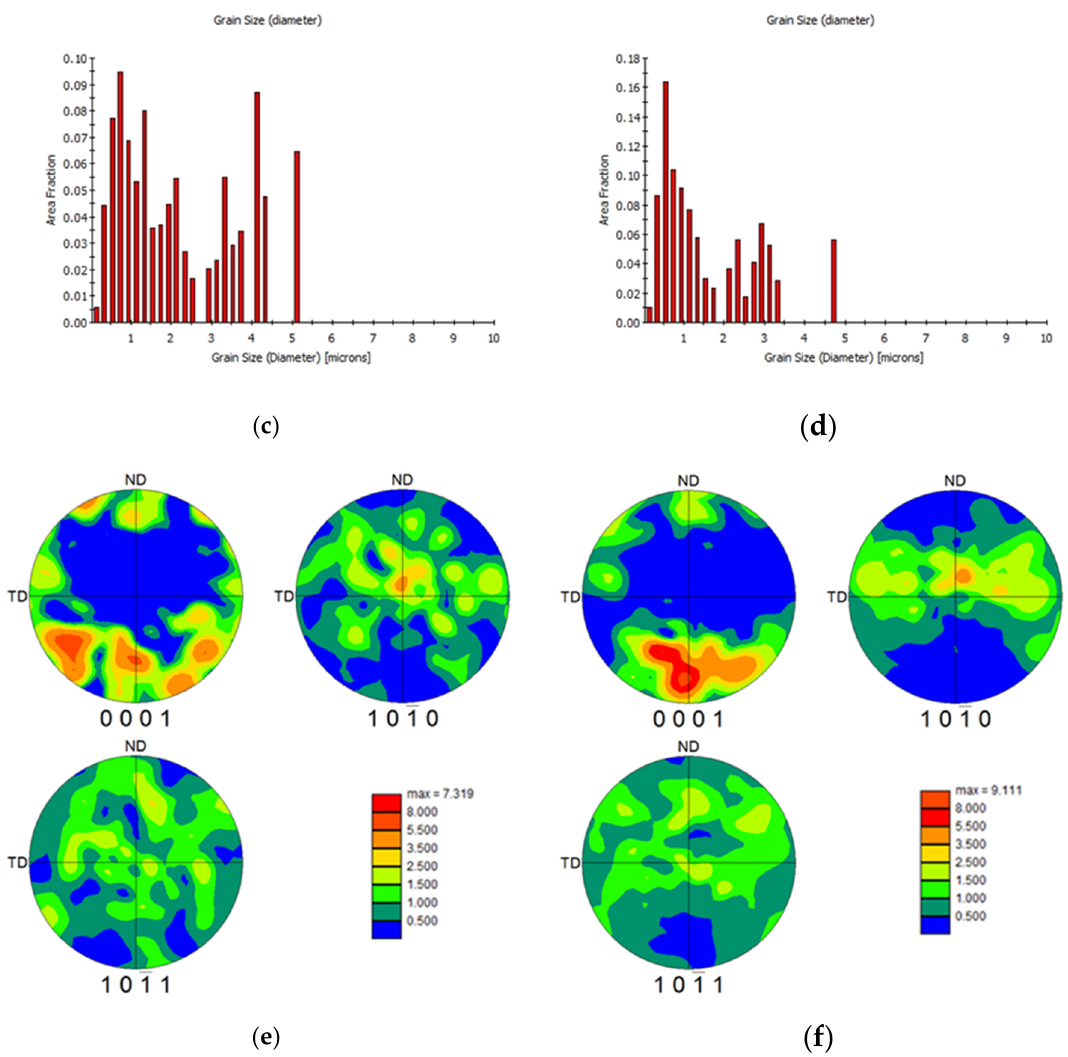
Figure 13. Orientation image maps of titanium Grade 2 ( a ) and Grade 4 ( b ), grain size distribution histograms of titanium Grade 2 ( c ) and Grade 4 ( d ), corresponding (0001), (101 ̅ 0), (101 ̅ 1) pole figures with the scale of intensities is shown as multiples of the random density (m.r.d.) from 0 to 8.000 for Conform SPD-ed titanium Grade 2 ( e ) and Grade 4 ( f ), respectively. High-angle grain boundary (HAGBs) (15°–100°) are indicated by black lines, low-angle grain boundary (LAGBs) (4°–15°) by white lines in Figure 13a,b (Rolling direction, “RD” perpendicular to the plane of sheet).